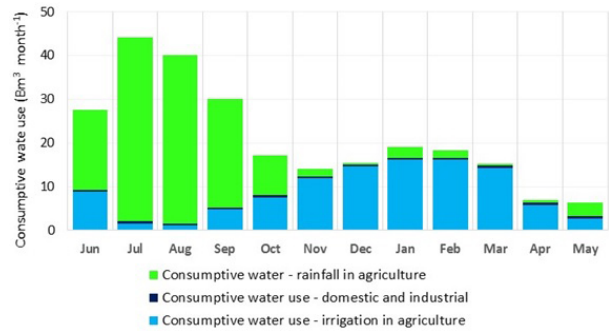
Figure 5. Average monthly CWU between 1999 and